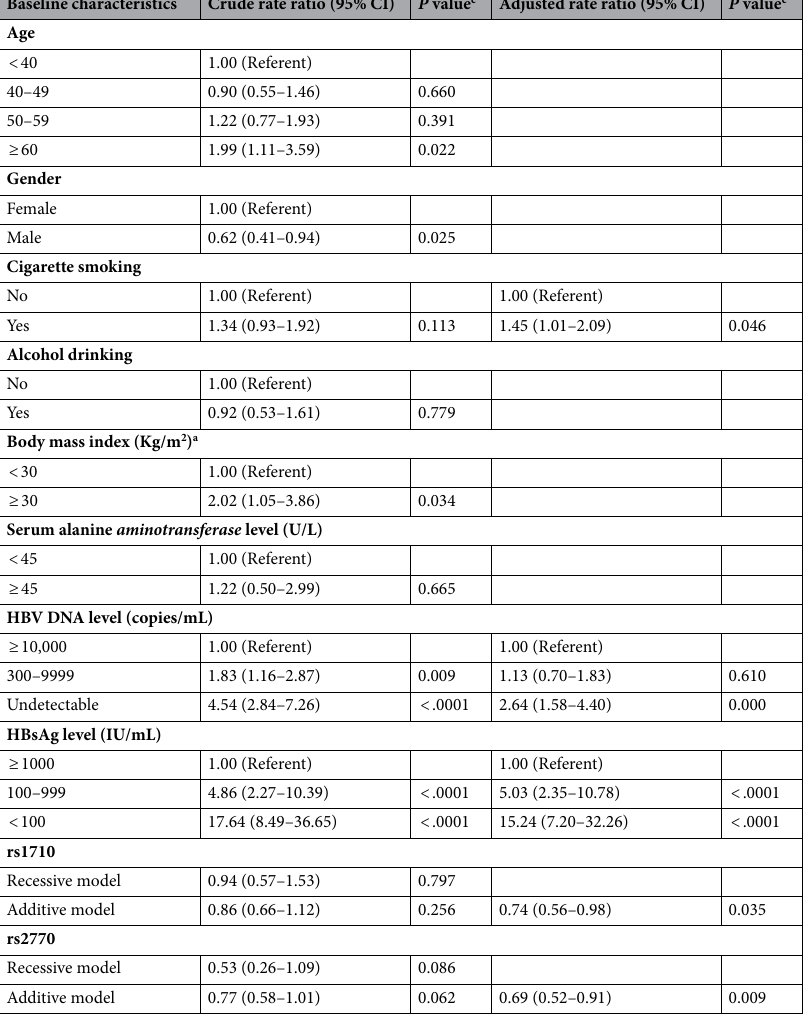
Table 3. Multiple predictors for the seroclearance of HBsAg in HBeAg-seronegative chronic hepatitis B patients with genotype B HBV infection. a One participant was missing for the data of body mass index. b Estimated by Cox proportional hazards